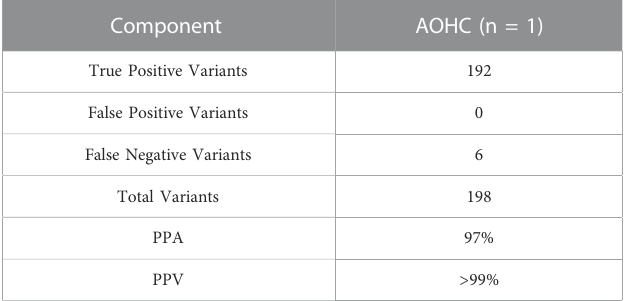
TABLE 10 Accuracy. PPA and PPV established by AcroMetrix Oncology Hotspot